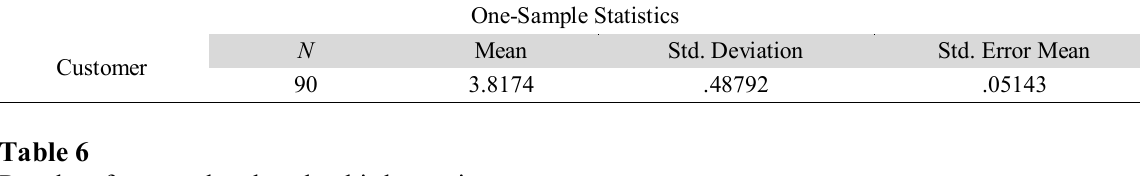
Results of t -test related to the third question